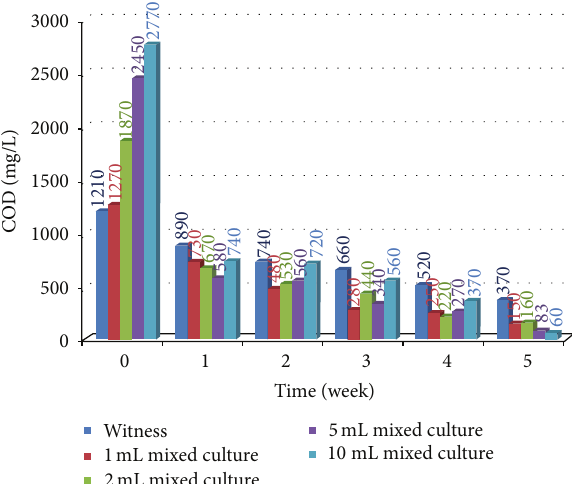
Figure 3: Chemical oxygen demand results in the